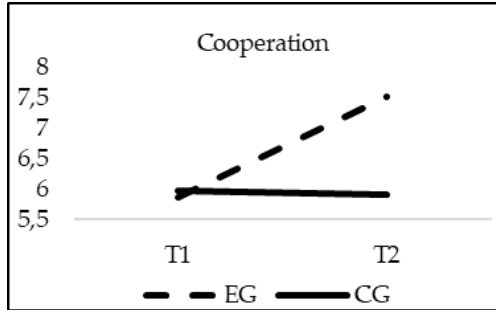
Figure 8. Interaction effects of group (EG-CG) and time (T1-T2) Cooperation.